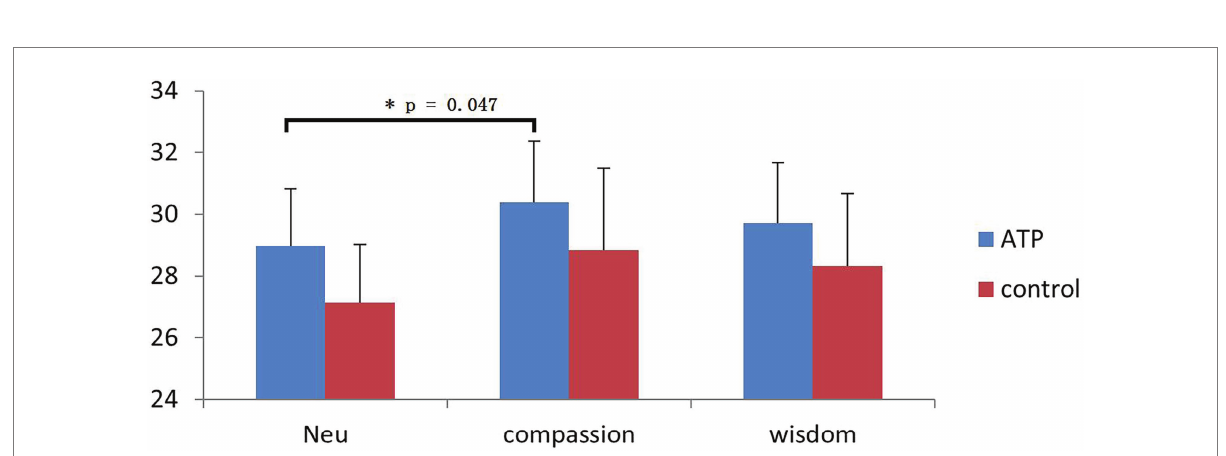
FIGURE 6 Group comparison of heartrate variability (HRV) under different conditions. The HRV is higher in the compassion condition than in the neutral condition in the Awareness Training Program (ATP) group. The error bar shows the standard